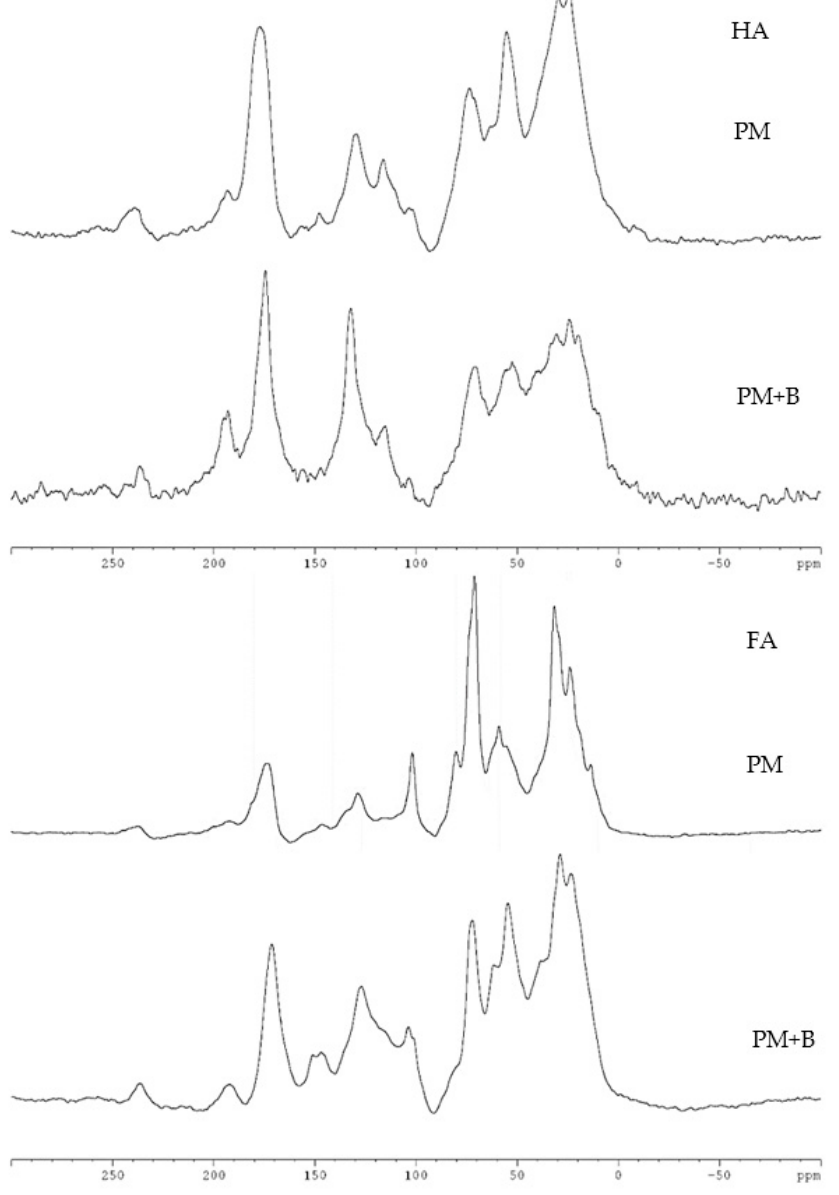
Figure 1. Cross-polarization magic angle spinning 13 C nuclear magnetic resonance (CPMAS 13 C-NMR) of humic acid-like (HA) and fulvic acid-like (FA) extracted from poultry manure compost (PM) and poultry manure blended with biochar (PM+B).